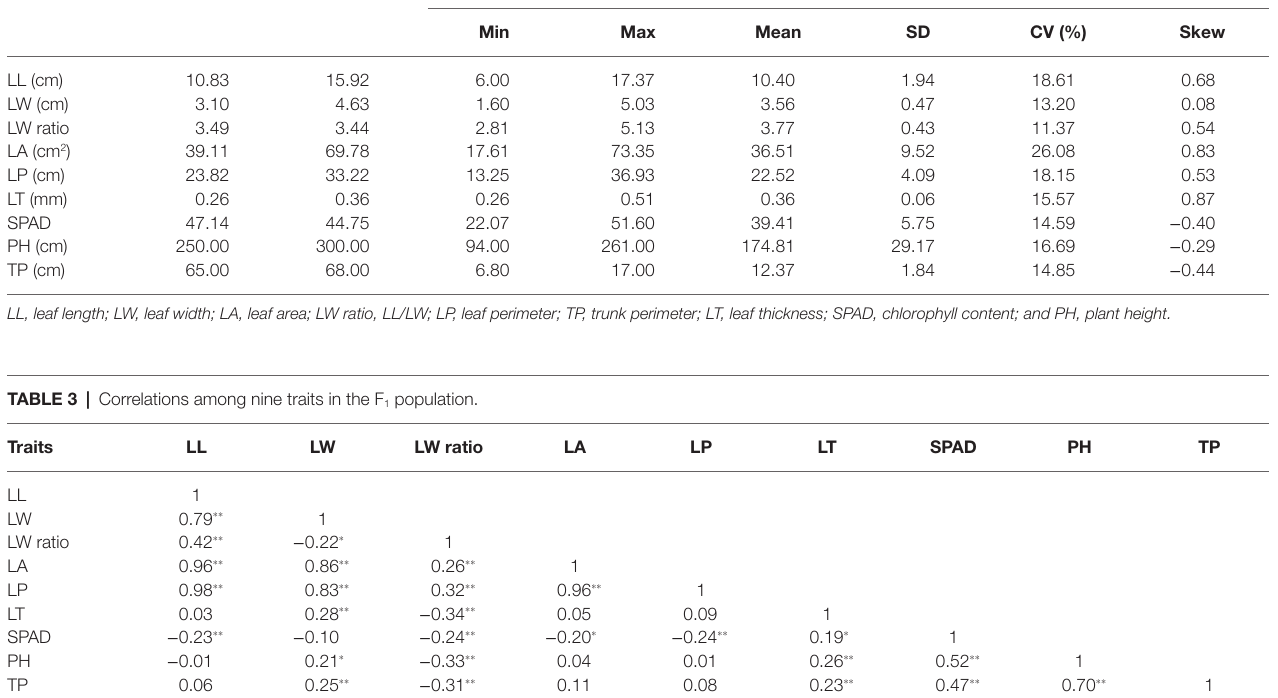
TABLE 2 | Biqizhong, 2012LXRM, and F 1 population phenotypic information. Traits